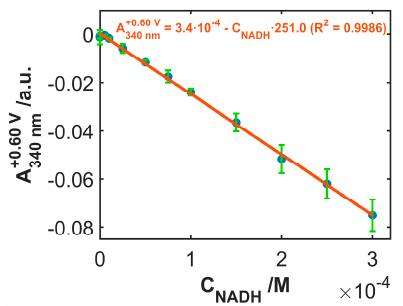
Figure 8. Calibration curve of the absorbance values at +0.60 V from the voltabsorptograms at 340 nm vs. NADH concentration. Each point has been replicated three times using the same electrode. Error bars, accounting for the standard deviation, are shown.